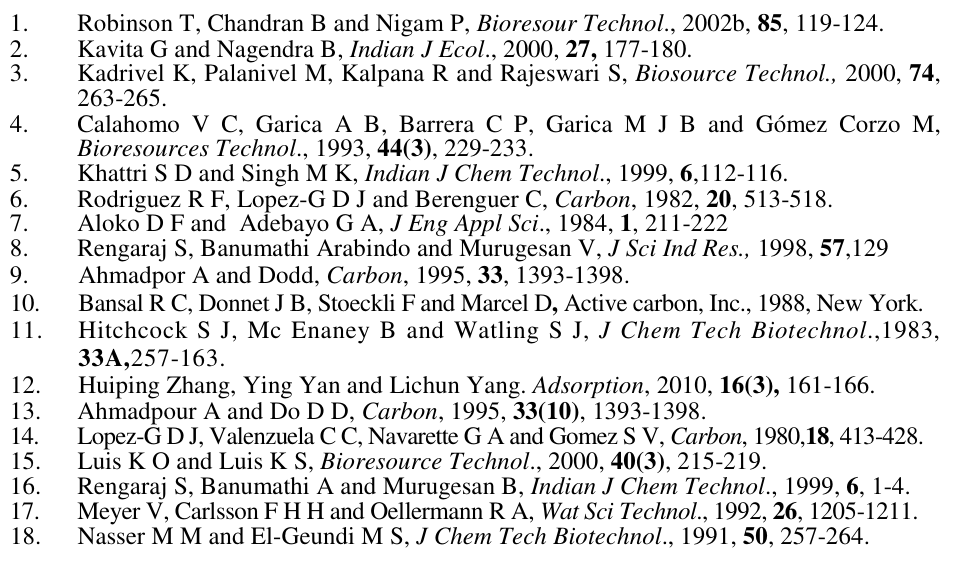
activated carbon 2